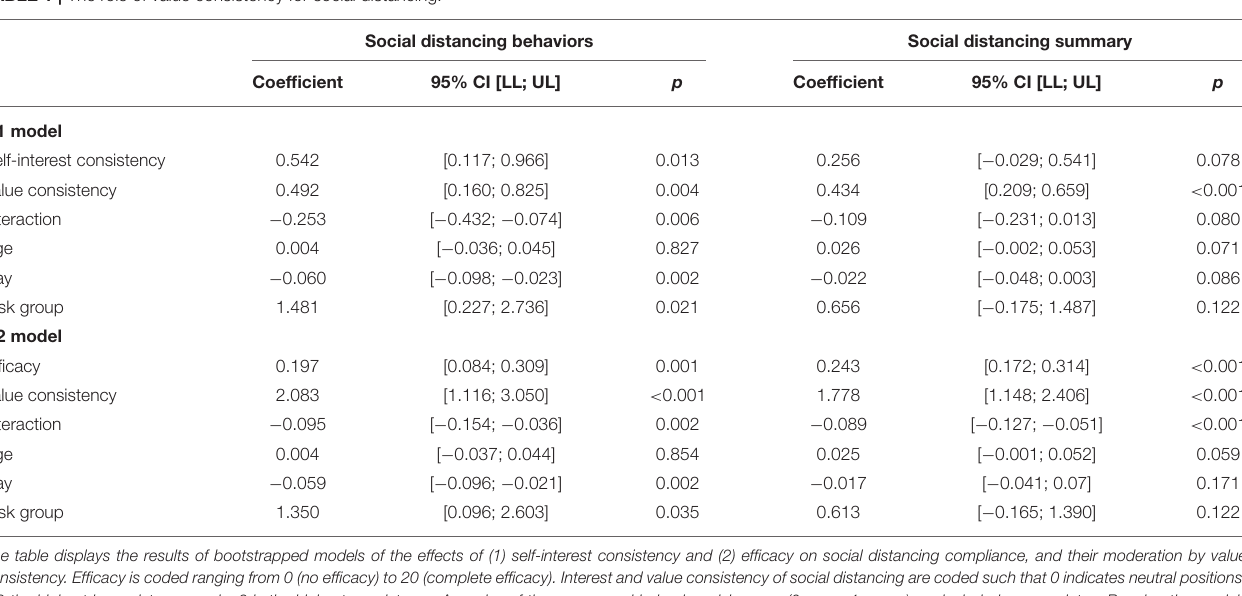
TABLE 1 | The role of value consistency for social distancing.